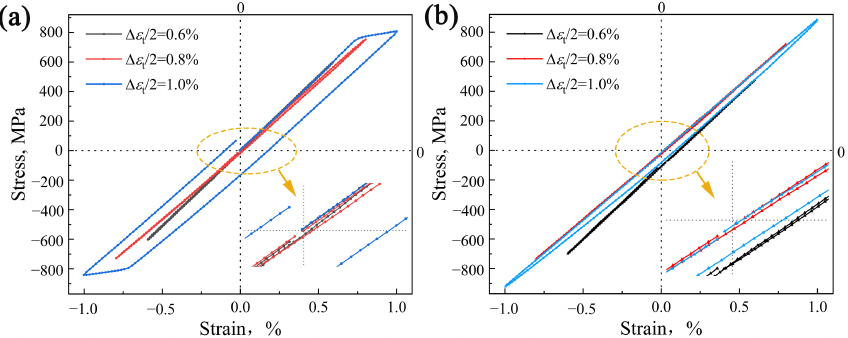
Figure 2. Typical hysteresis loops of the alloy under varying strain amplitudes: ( a ) first cycle and ( b ) stabilized cycle. ( b ) stabilized